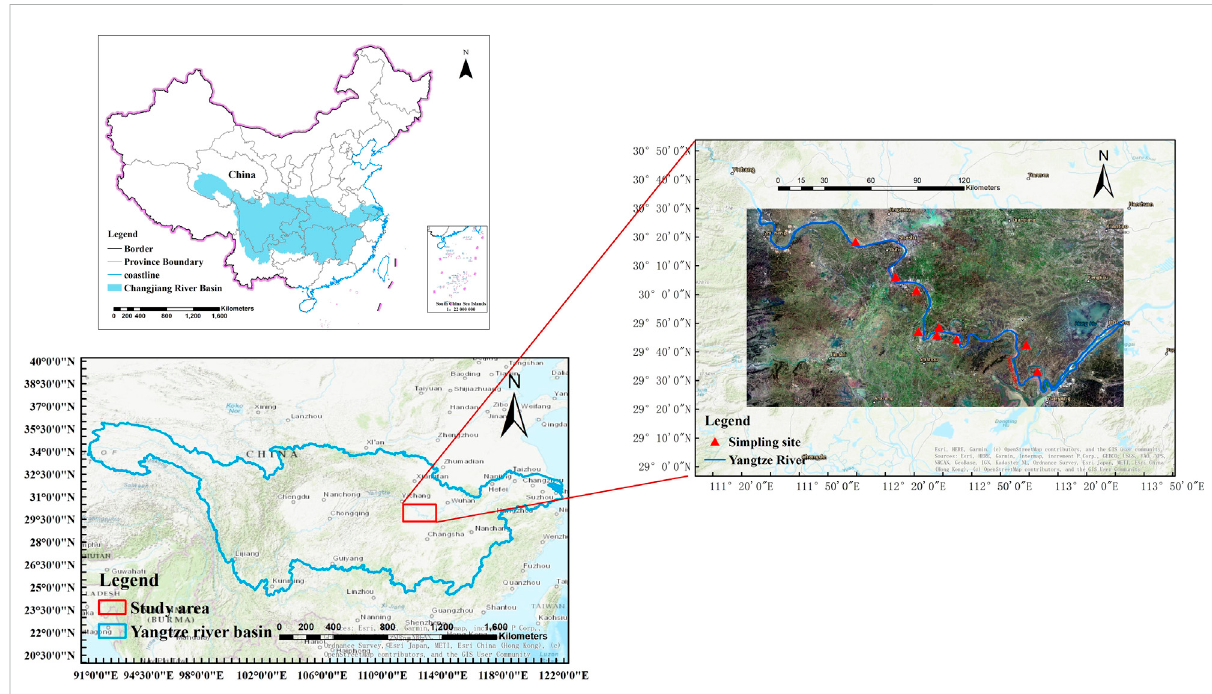
FIGURE 5 Sampling sites of experimental Oncomelania s of the Jingzhou fragment (the middle reach) of Changjiang River.